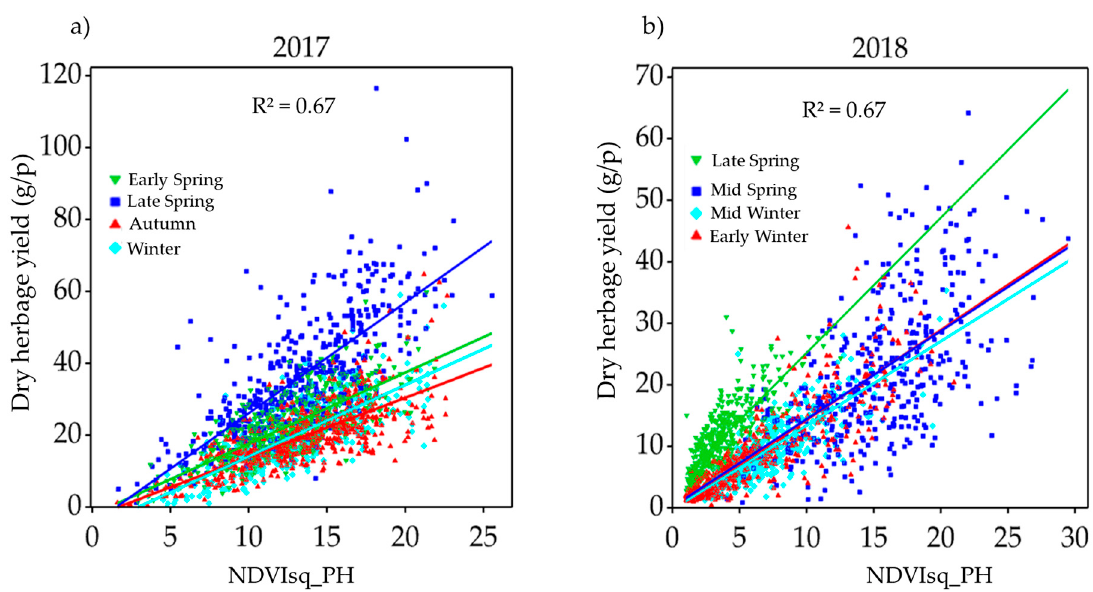
Figure 8. Scatterplots of ( a ) combined regression of NDVIsq_PH vs. dry herbage yield measurements of single plants in four seasons of 2017; ( b ) combined regression of NDVIsq_PH vs. dry herbage yield measurements of single plants in four seasons of 2018. p -value < 0.001 for all regression equations.